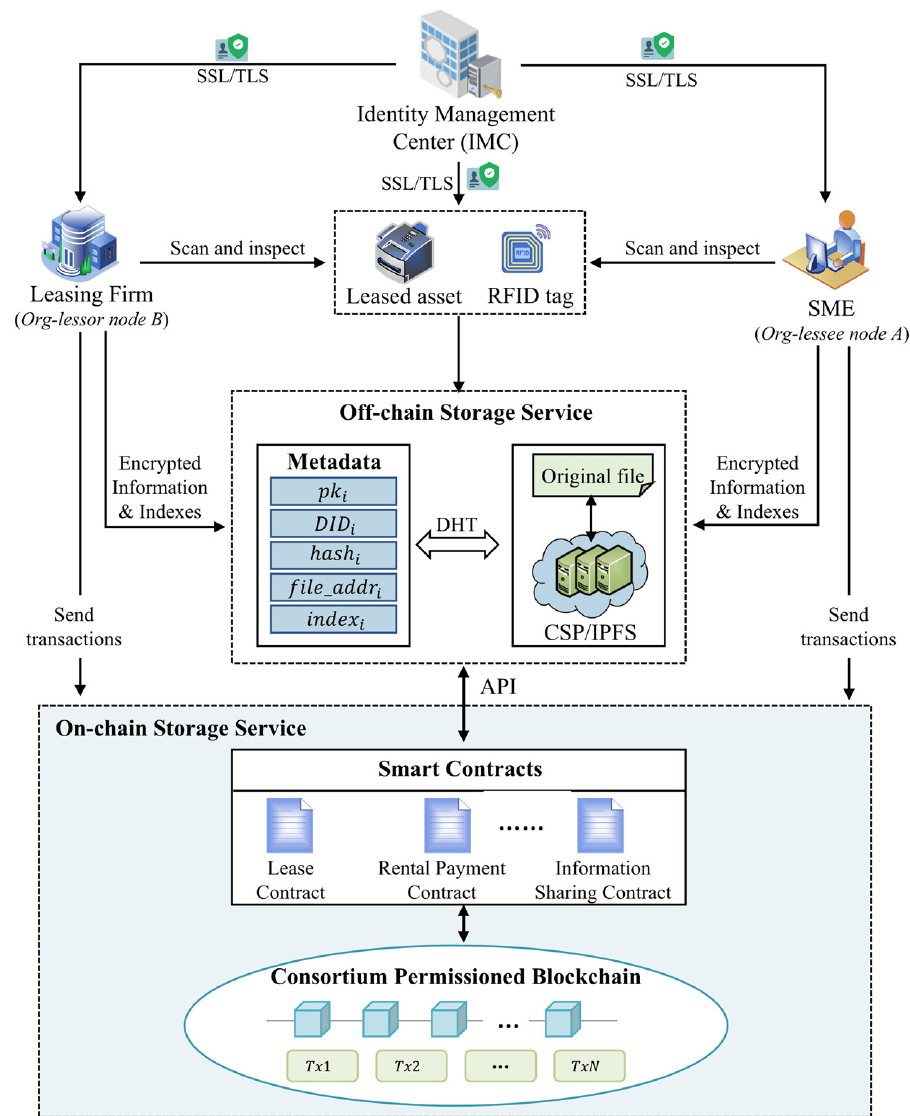
Figure 1. The architecture of CBLP with an on- and off-chain information storage mechanism.